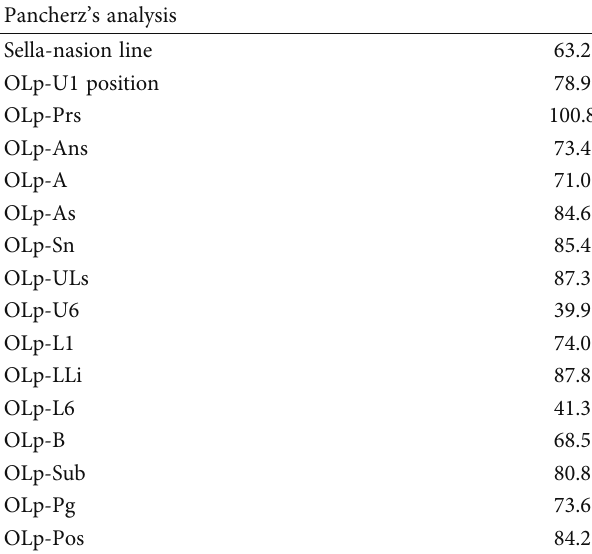
Figure 20: Cephalometric superimposition post-Herbst.